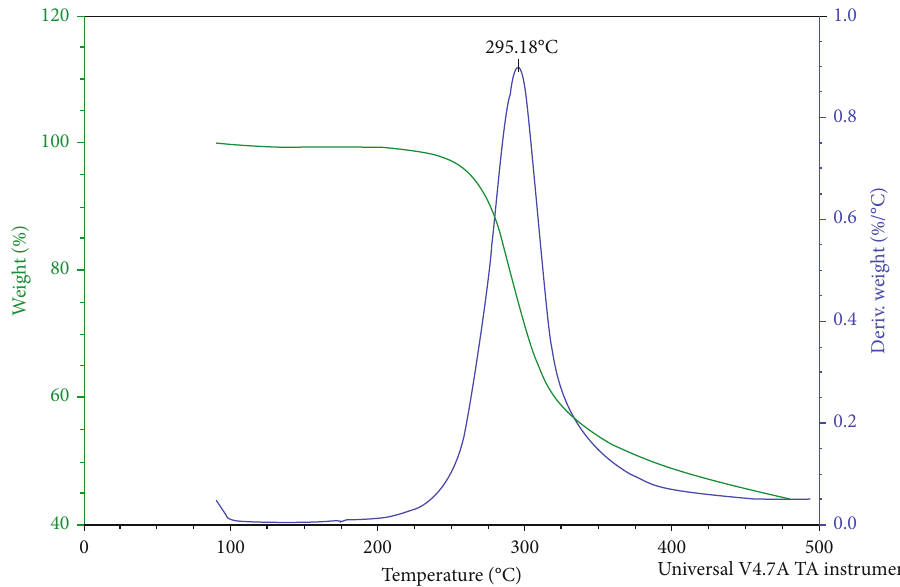
Figure 5: TGA of chitosan shows the decomposition temperature (295.18 ° C) obtained at a heating rate of 10 ° C/min in nitrogen gas fl ow.